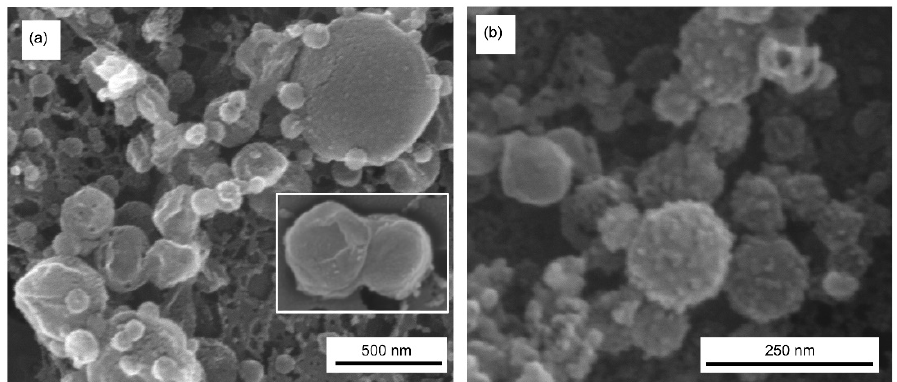
Figure 6. Scanning electron microscopy (SEM) images of granum ( a ) and stroma ( b ) TMs, captured using accelerating voltages of 2 and 15 kV, respectively, of the EM. Inset in ( a ), an example of two apparently fused grana.